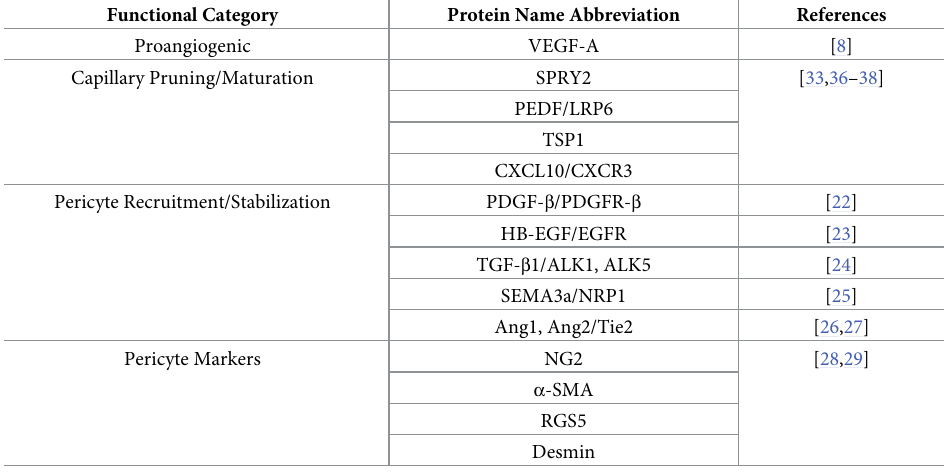
Table 2. Proangiogenic, capillary pruning/maturation, and pericyte-associated factors and